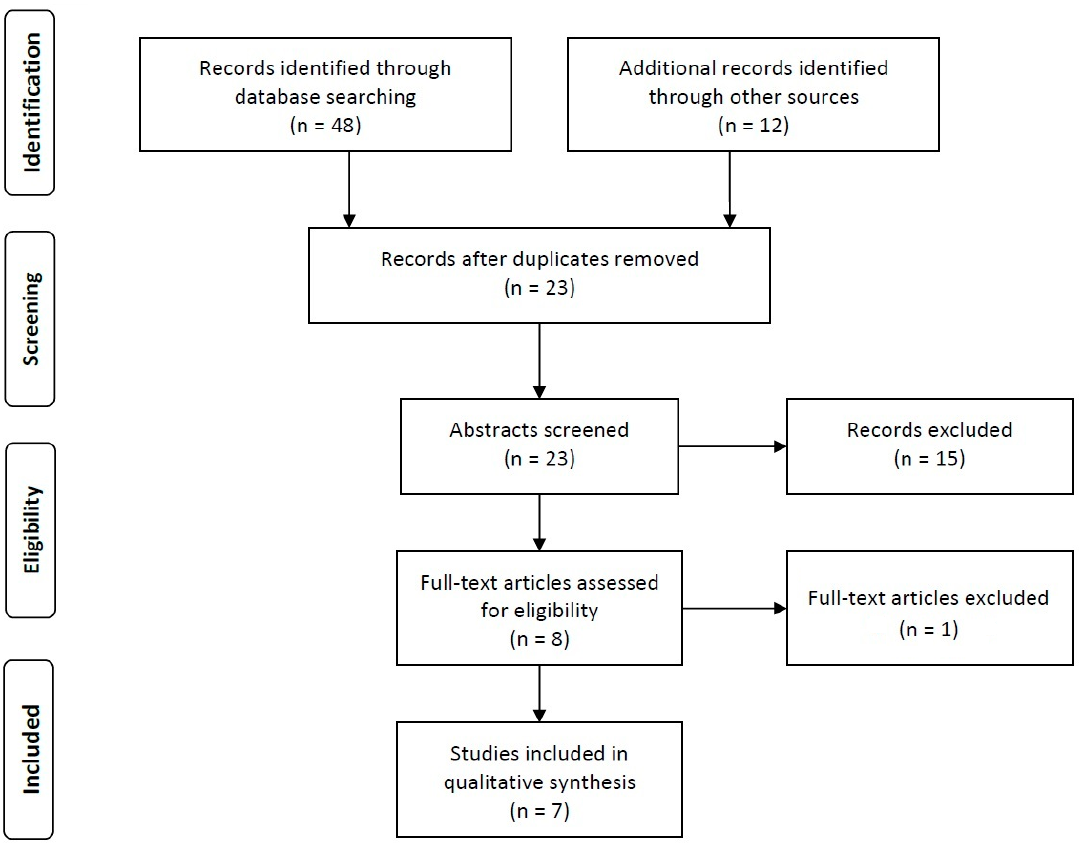
Figure 2. Flow chart of the literature search.